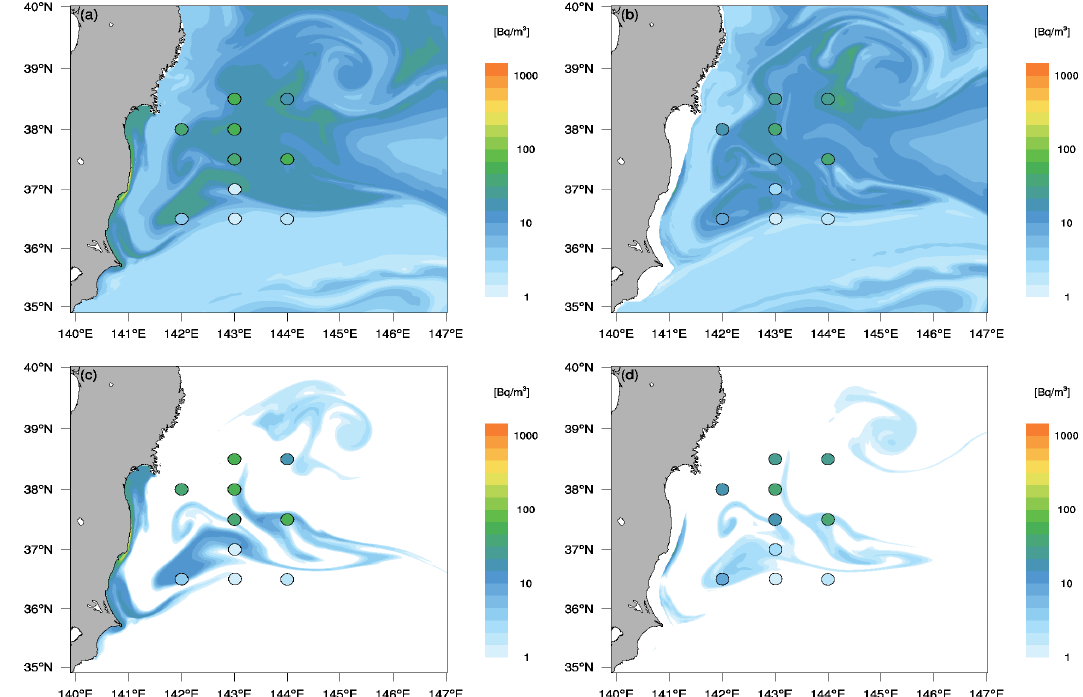
Fig. 12. Simulated 137 Cs activities (Bqm − 3 ) (ALL scenario) on 2 December 2011 (a) in surface waters and (b) at a depth of 100m and observations from 30 November to 2 December 2011. Simulated 137 Cs activities (D RELEASE scenario) (c) in surface waters and (d) at a depth of